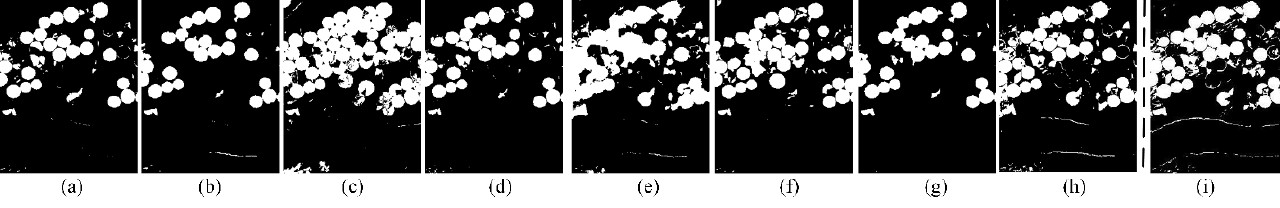
Figure 12. Detection details of the selected regions R 1 , R 2 , and R 3 on the USA dataset using different methods: ( a ) CVA, ( b ) SSIM, ( c ) ISFA, ( d ) IRMAD, ( e ) MaxtreeCD, ( f ) Unet, ( g ) SGCL, ( h ) SSCF, ( i ) Ground-truth.